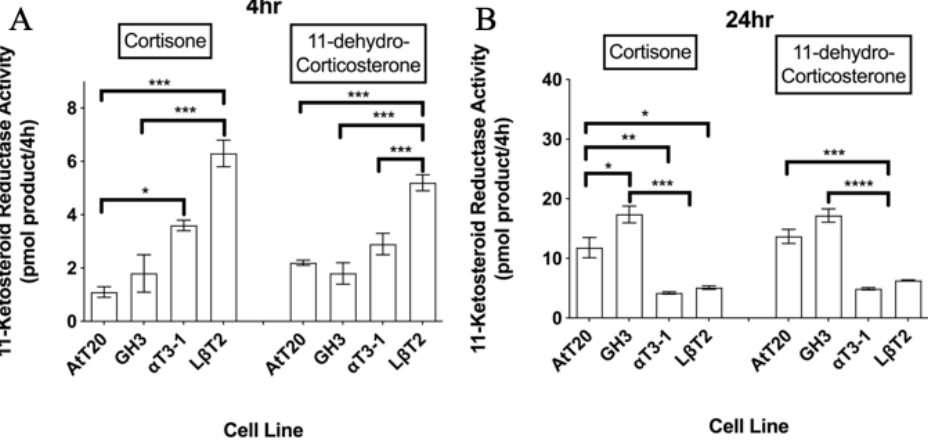
Figure 2. 11-ketosteroid reductase activities in four pituitary cell lines measured over ( A ) 4 h or ( B ) 24 h using 100 nM [ 3 H]-cortisone and 100 nM [ 3 H]-11-dehydrocorticosterone as enzyme substrates. Data shown are mean ± SEM for three di ff erent cell passages pooled together (n = 3) (with triplicate measures in each passage). For a given time point and substrate, mean values with di ff erent superscripts di ff er significantly ( p < 0.05) (one-way ANOVA with the Tukey–Kramer multiple comparison as the post hoc